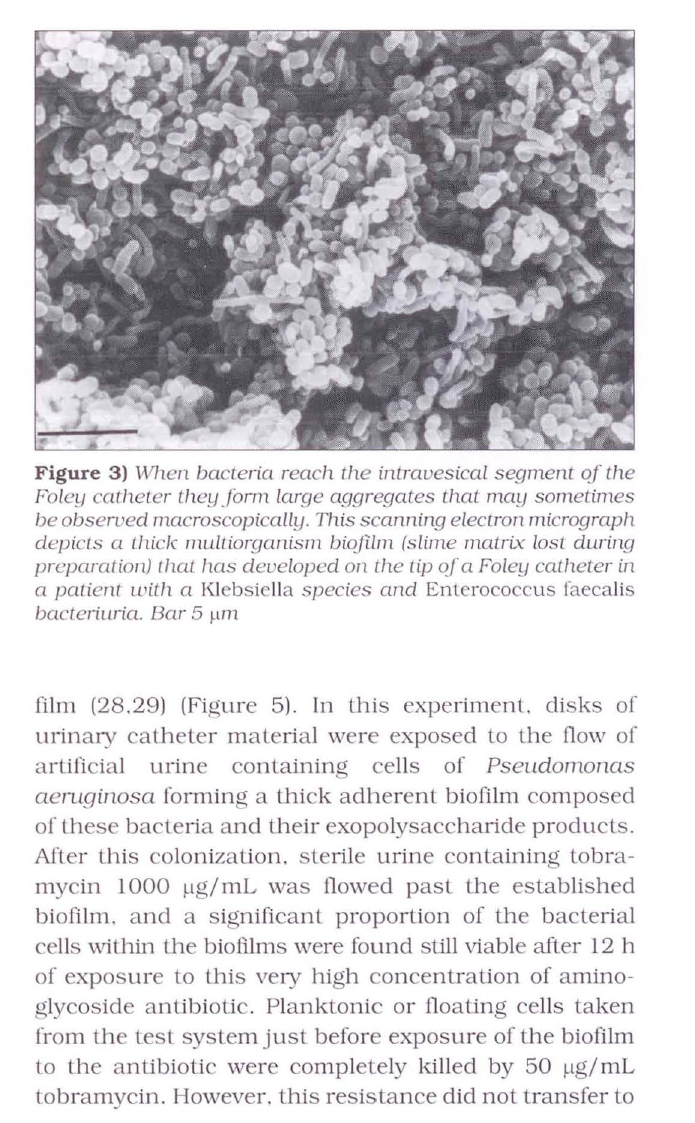
Figure 2) Scanning electron micrograph of experimental bac terial biojllm (lower lt;ft! ascending the luminal. surface of a